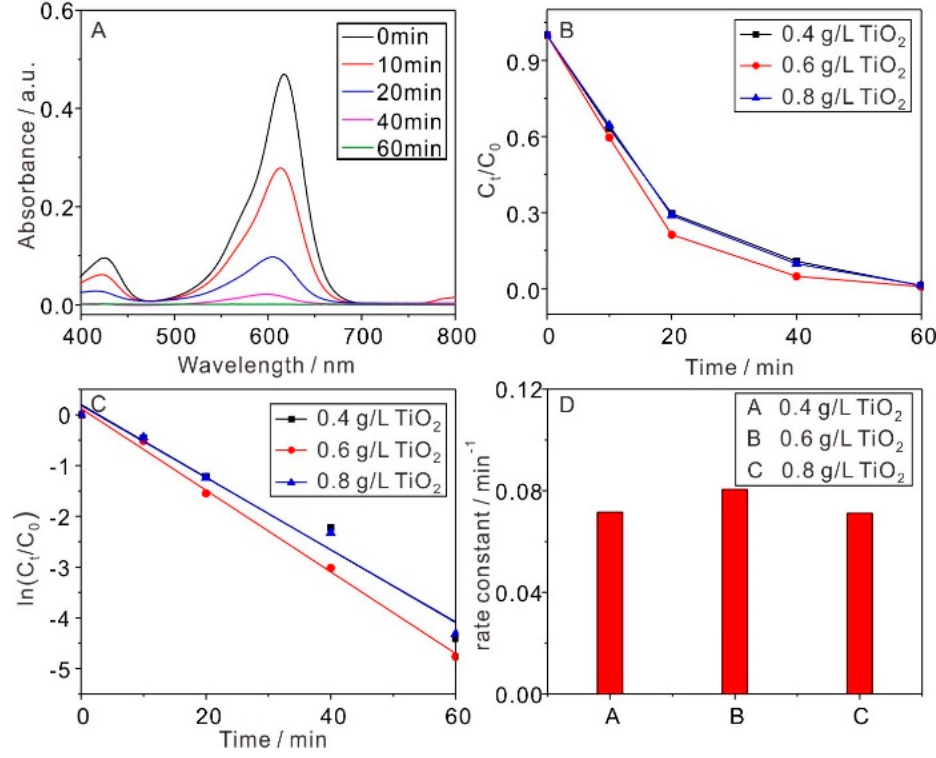
Figure 3. ( A ) Time-course UV-Vis absorbance spectra of MG (10 − 5 M) photocatalyzed by 0.6 g/L TiO 2 under UV light; ( B – D ) The calculated time-dependent ratios of C t / C 0 , first-order degradation rates, and reaction rate constants under UV light with different TiO 2 dosage. Table 1. Comparison of pseudo first-order model parameters, rate constants ( k , min –1 ) and R 2 under different TiO 2 dosages.